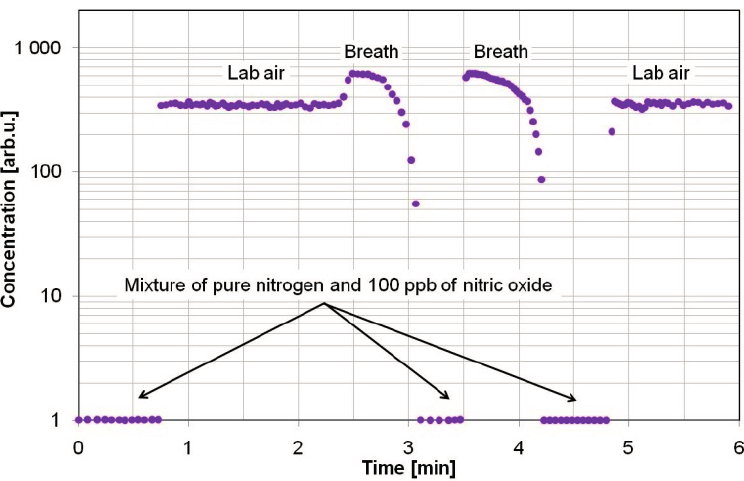
Figure 5. Example of the NO concentration measurements in human breath at atmospheric